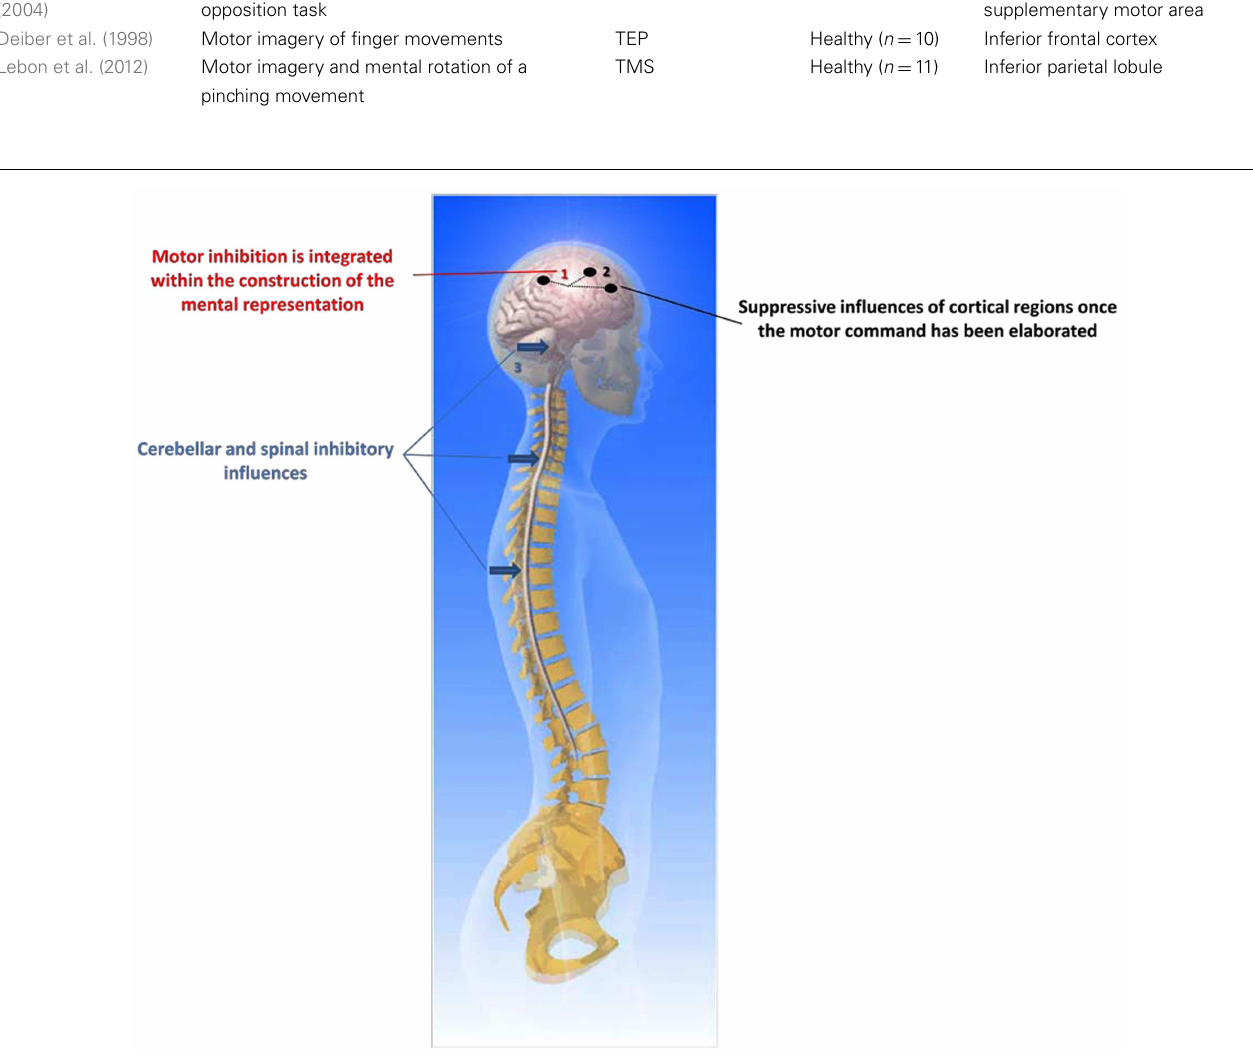
FIGURE 1 |The three possible routes of motor command inhibition during motor